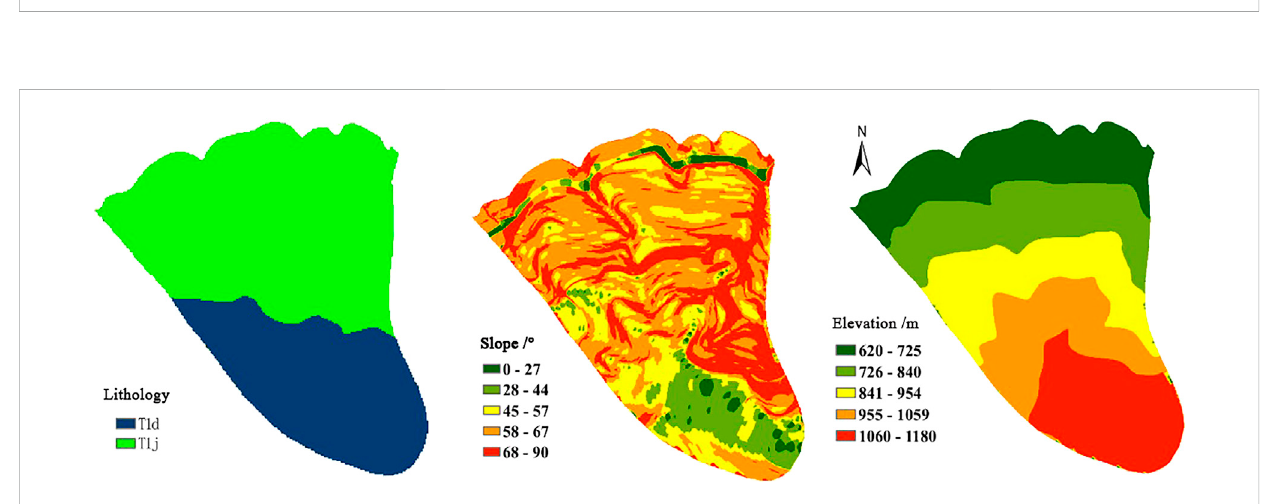
FIGURE 4 Lithology, slope, and elevation distribution